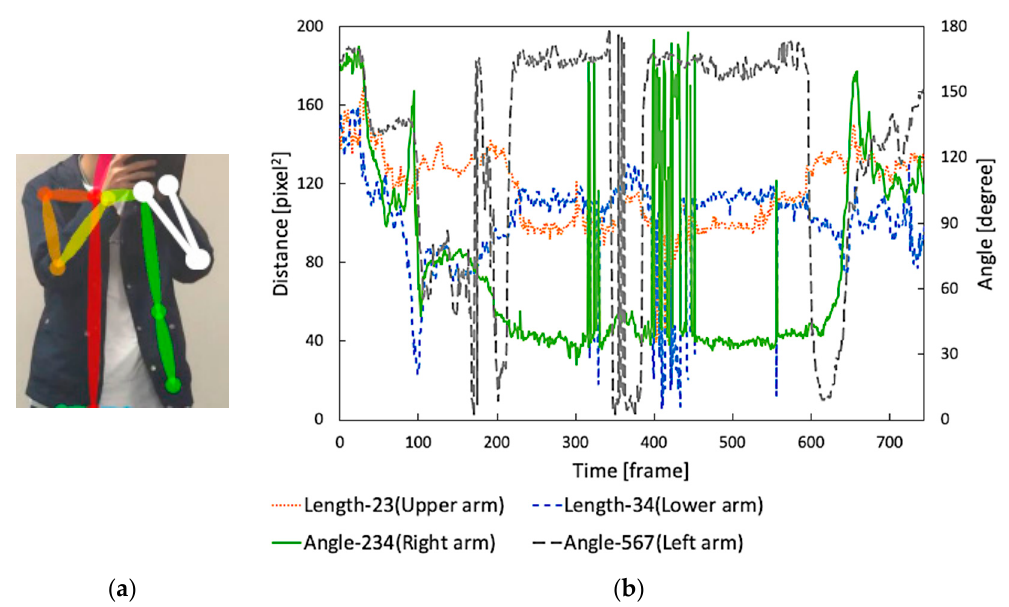
Figure 14. Example 2 of misdetection generated by OpenPose (taken from P5). ( a ) Misdetection frame (white line presents an expected detection result); ( b ) result of the right upper and lower arms’ lengths and the angle of right/left bending arms. In ( b ), first vertical axis indicates distance between joints (length) (pixel 2 ). Second vertical axis indicates angle (degree). Horizontal axis indicates frame number corresponding to time (frames).